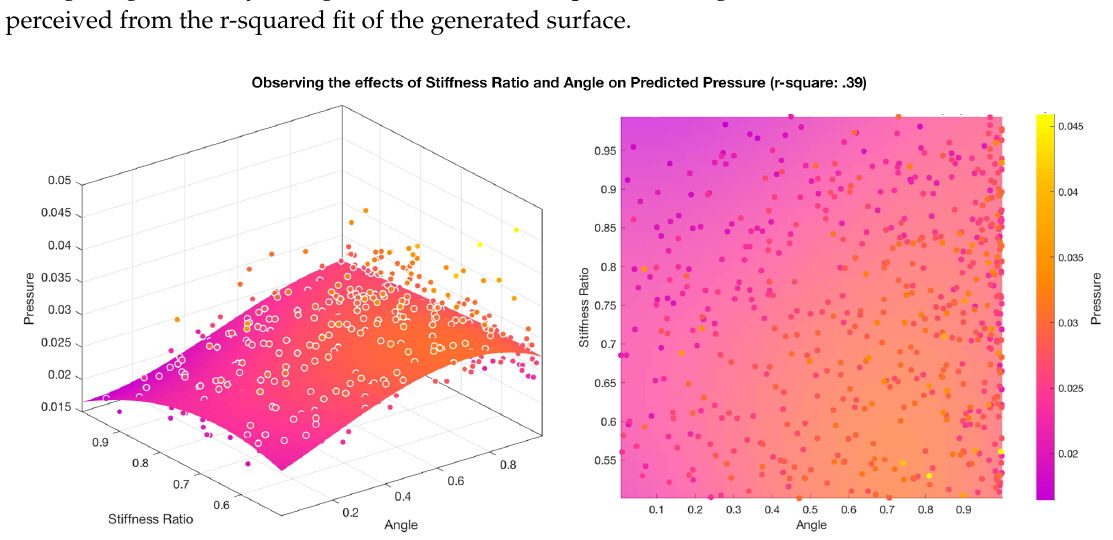
Figure 16. Stiffness ratio vs angle vs. pressure with gradient surface